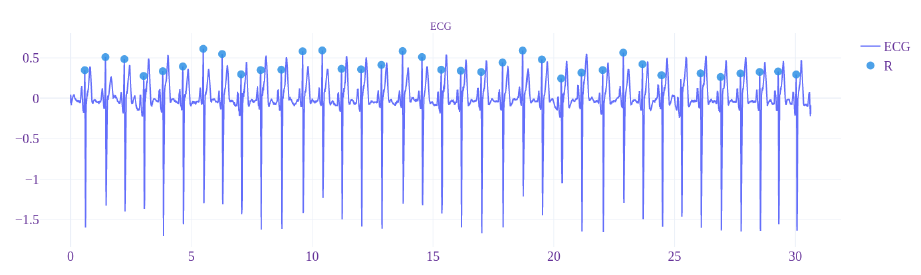
Figure 9. The result of application of the proposed R wave distinguishing algorithm on the signal of ECG that is acquired by using TEPC-4.